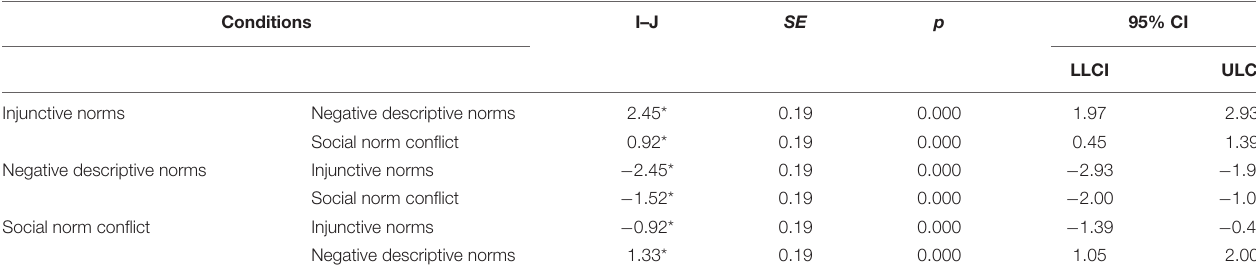
TABLE 1 | Multiple comparisons of green consumption of three